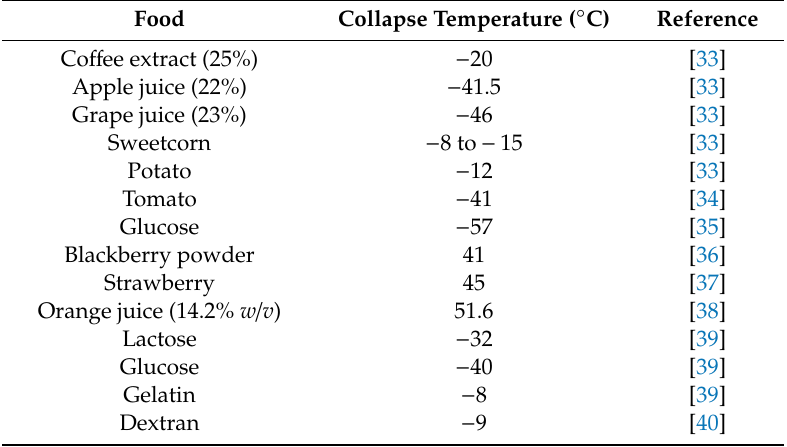
Table 1. Collapse temperature for selected foods during